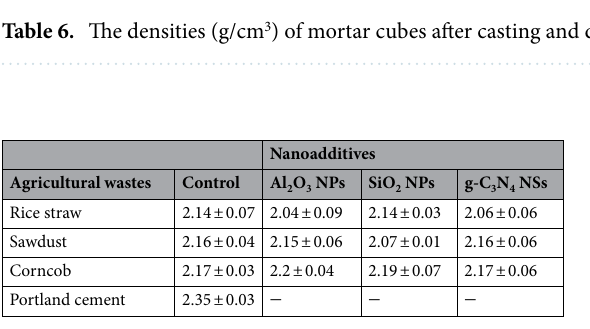
Table 7. The densities (g/cm 3 ) of mortar cubes after 28 days of curing.